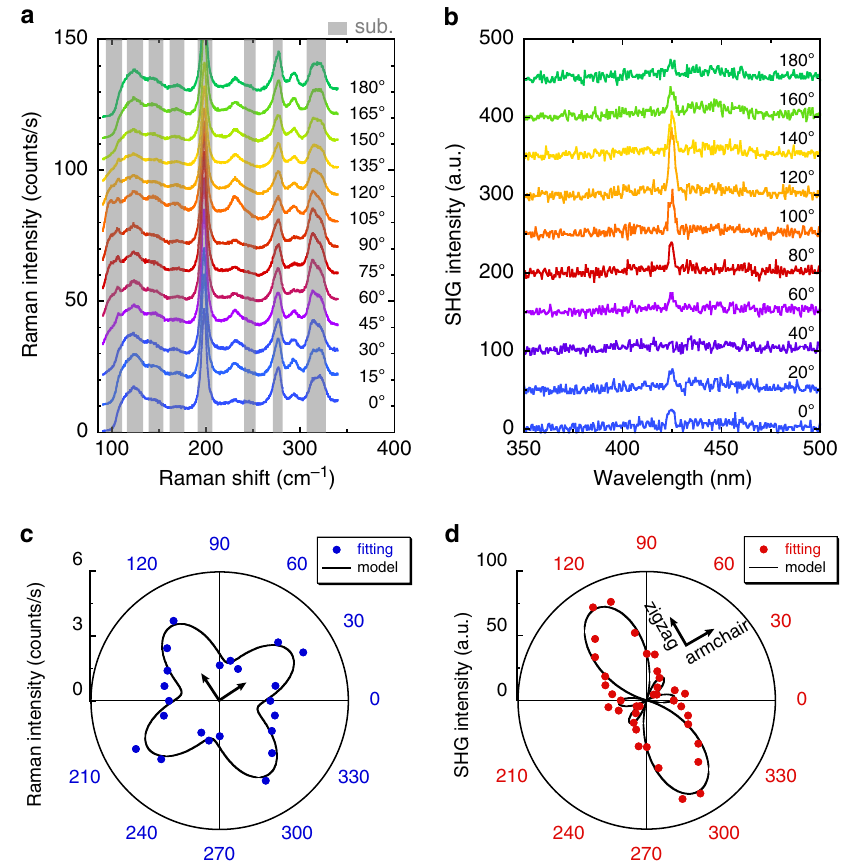
Fig. 2 Optical anisotropies of monolayer SnS. a , b Polarization dependences of Raman (3 K) and SHG (RT) spectrum of monolayer SnS, with parallel and perpendicular polarization, respectively. The gray shaded region of Raman spectra represents Raman peak from mica substrate. c , d Polar plots of Raman intensity at ~234.0 cm − 1 and SHG intensity at 425 nm, respectively. The inset axes show the armchair and zigzag directions.